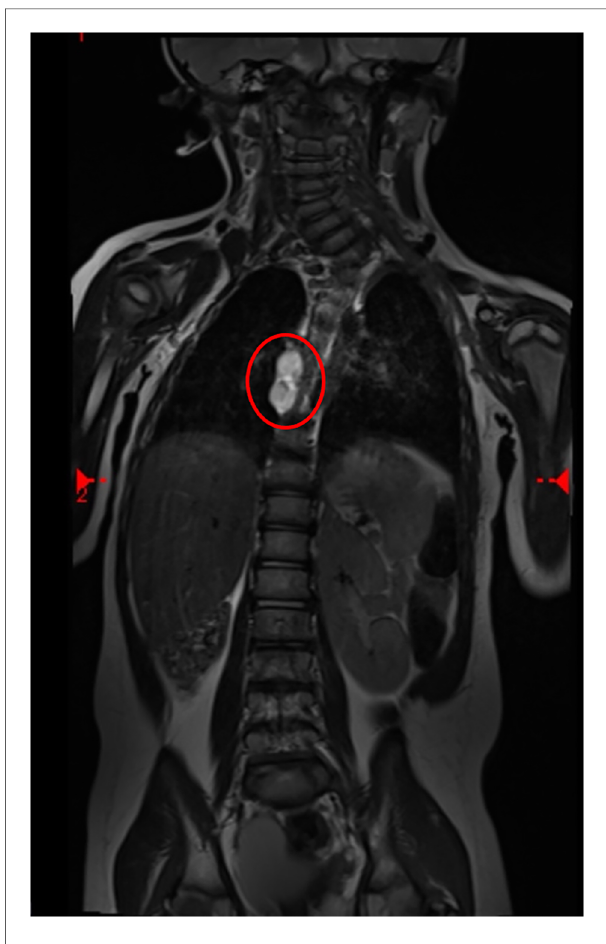
FIGURE 1 MRI scan of cystic lesions of the esophagus (circle: EDC at the D7 – D9 level).